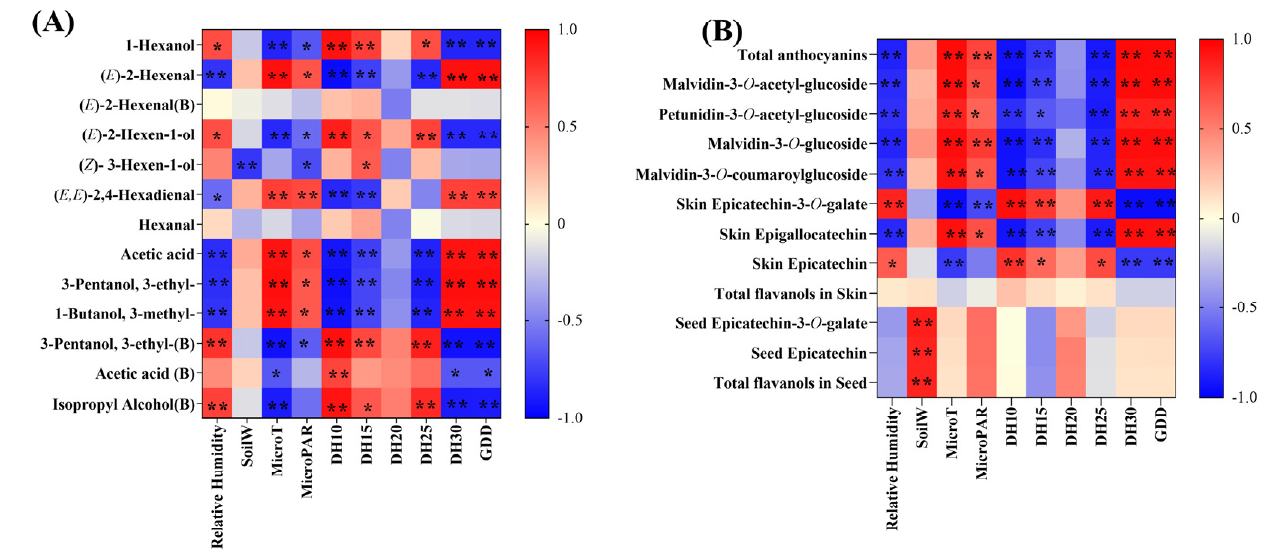
2018 and 2019. There were no significant differences in the residual sugar and the volatile acidity between treatments.